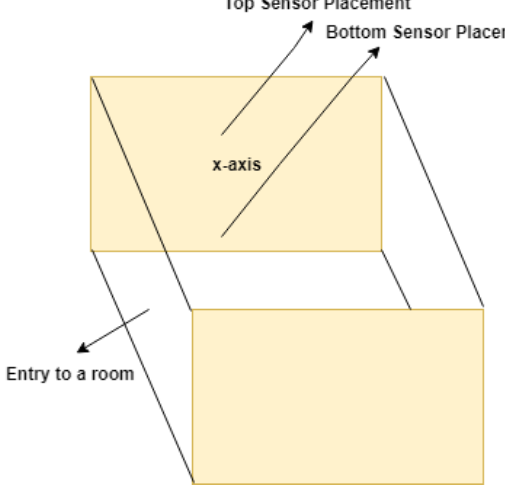
Figure 5. Pictorial representation of the hardware